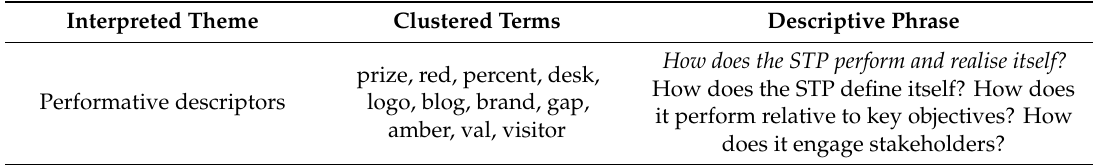
Table 5. Interpretation of hierarchical